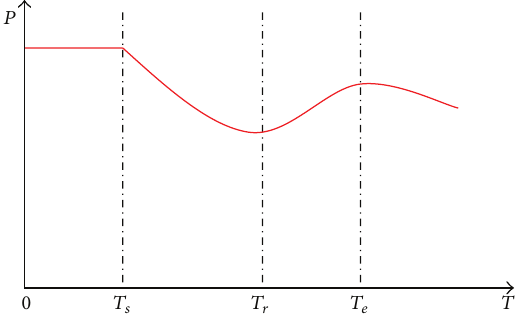
Figure 1: Resilience description of cluster supply chain network.